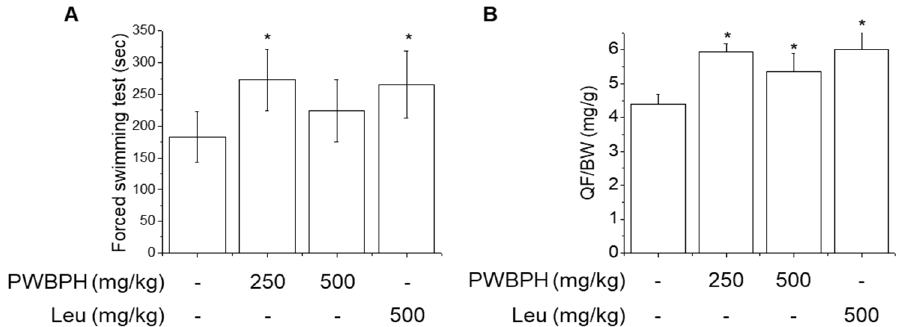
Figure 1. Effect of PWBPH on endurance performance and muscle weight. ( A ) Exercise function was determined based on the time to exhaustion in the forced swimming test ( n = 6). ( B ) QF muscle/body-weight ratios in the control, PWBPH 250, 500 mg/kg, and Leu 500 mg/kg groups ( n = 6). * p < 0.05 vs. control group. Abbreviations: QF, quadriceps femoris; BW, body weight). A low dose (250 mg/kg) of PWBPH exerted a greater effect on endurance capacity, QF muscle gain, and anti-muscle fatigue, compared to 500 mg/kg PWBPH, suggesting that 250 mg/kg is the optimal dose in mice. Therefore, the 250 mg/kg PWBPH group was used to investigate muscle fiber type conversion. Table 1. Levels of blood markers following exercise-induced muscle fatigue. Group Data are shown as the means ± SD. * p < 0.05 vs. control group. Abbreviations: BUN, blood urea nitrogen; CK, creatine kinase).